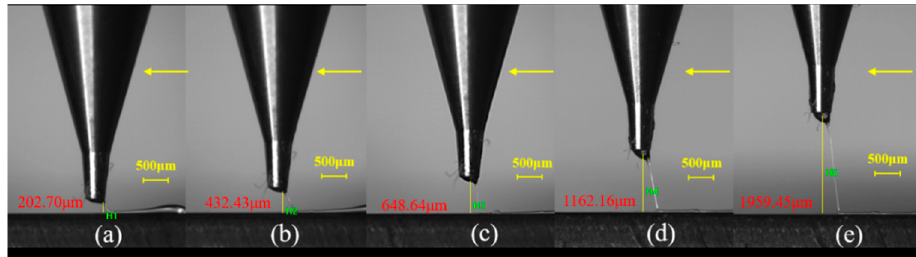
Figure 8. Stable deposition of continuous cone jet at an effective deposition height. ( a ) H is 202.70 µ m; ( b ) H is 432.43 µ m; ( c ) H is 648.64 µ m; ( d ) H is 1162.16 µ m; ( e ) H is 1959.45 µ m.